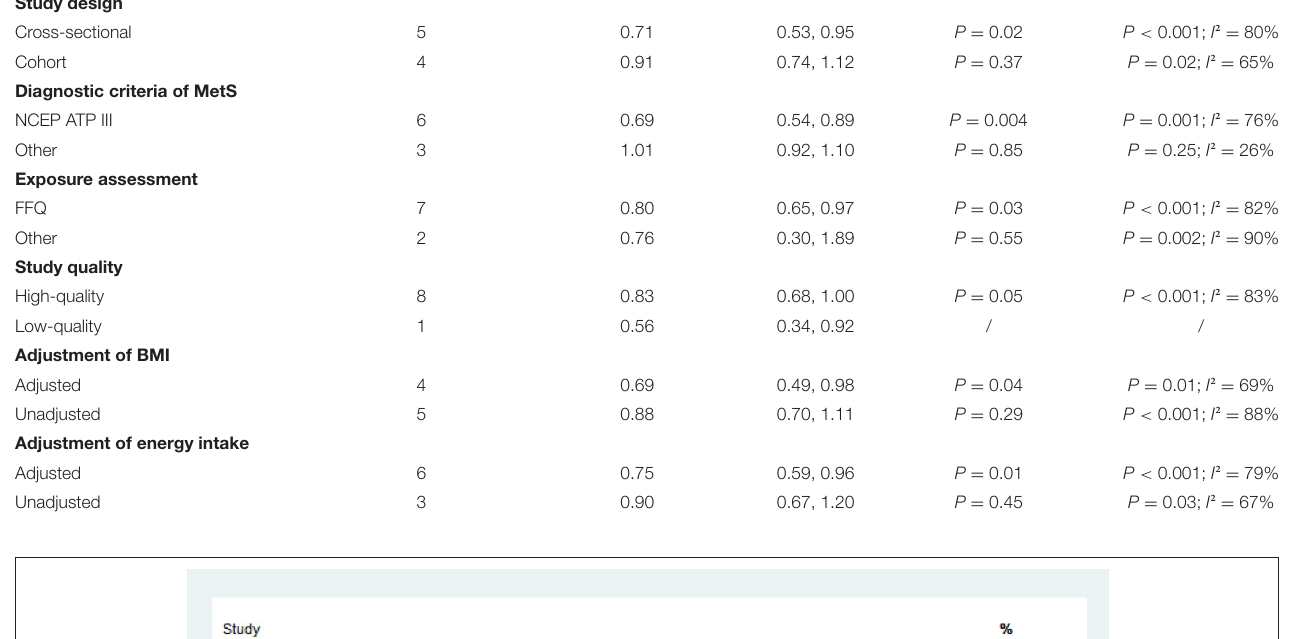
TABLE 2 | Subgroup analyses of whole grain consumption and MetS.